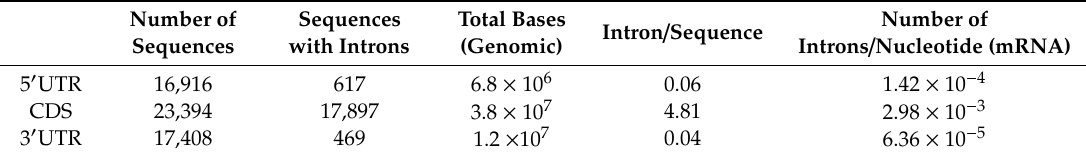
Table 1. Statistics information of 5 (cid:48) untranslated regions (UTR), coding sequences (CDSs) and 3 (cid:48) UTR in Citrus sinensis